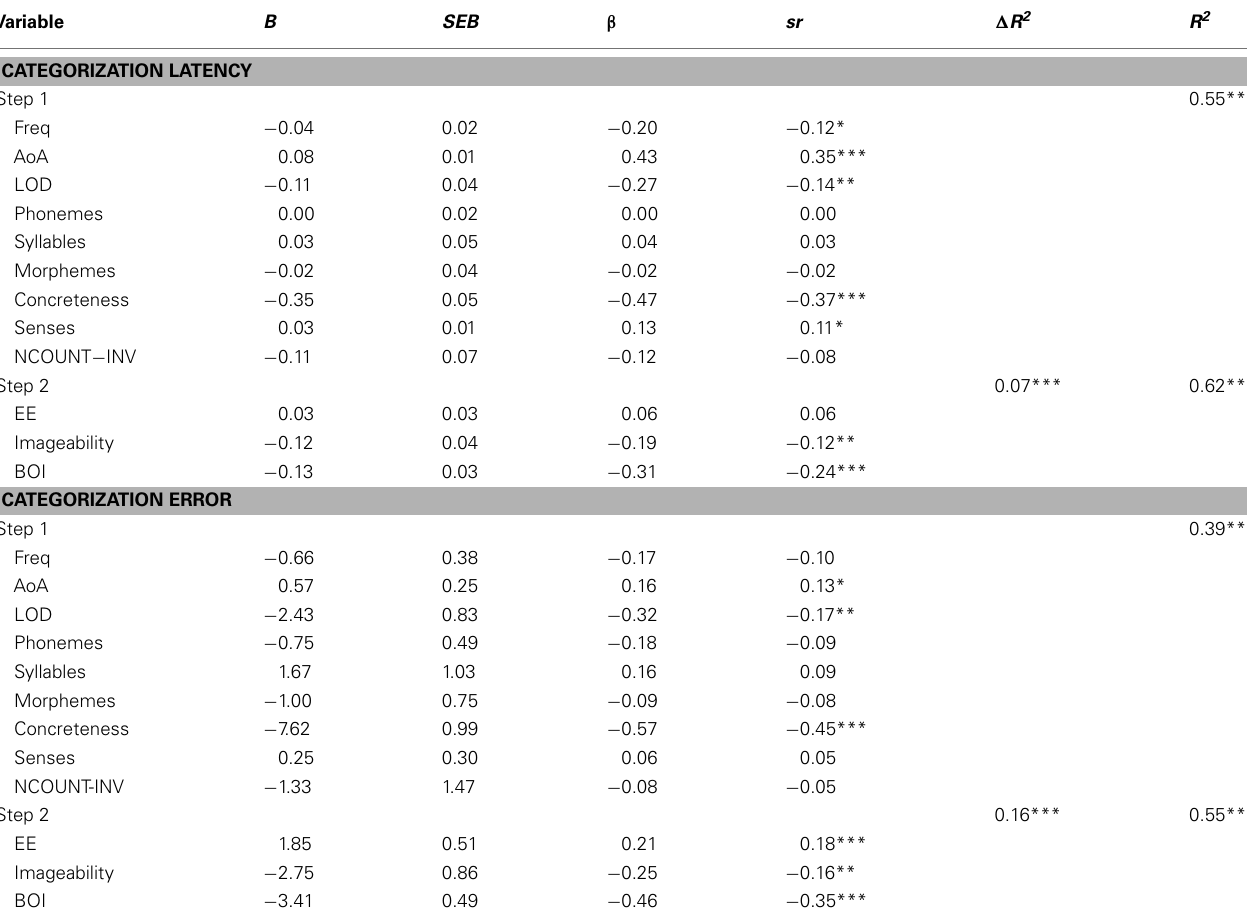
Table 5 | Results of hierarchical multiple regression analyses for the concrete